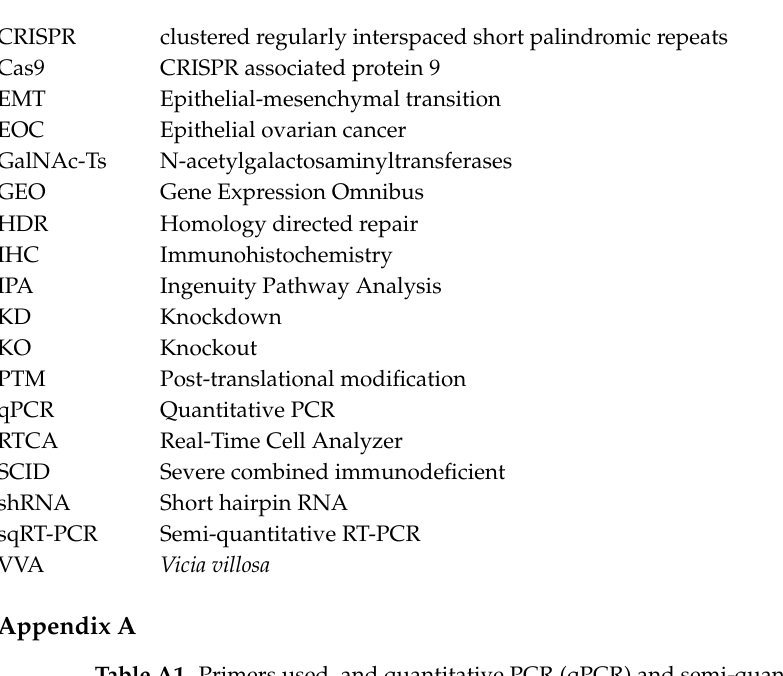
Table A1. Primers used, and quantitative PCR (qPCR) and semi-quantitative PCR